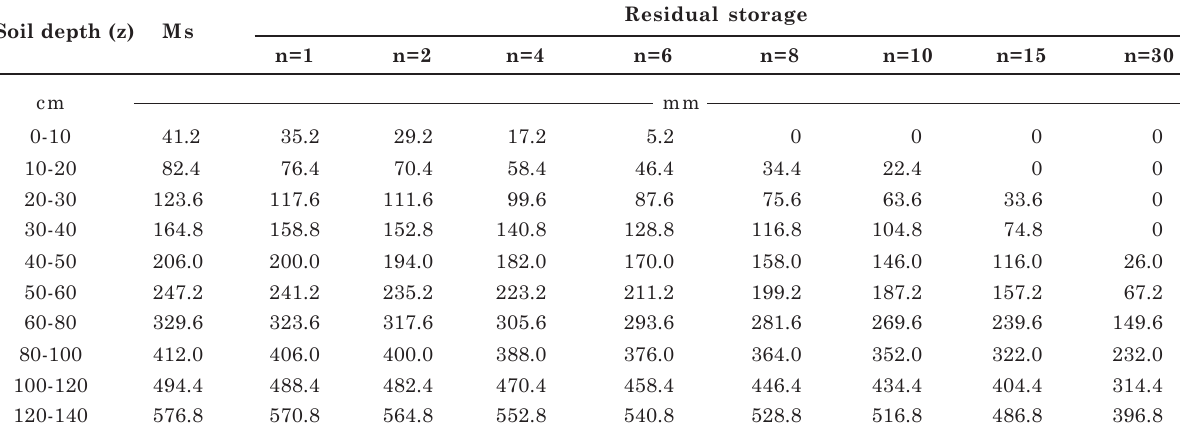
Ms: maximum water storage in the